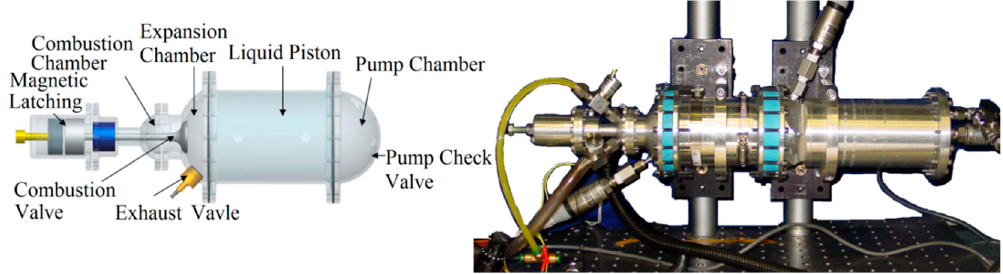
Figure 22. The free-piston engine prototype of Vanderbilt University [57].